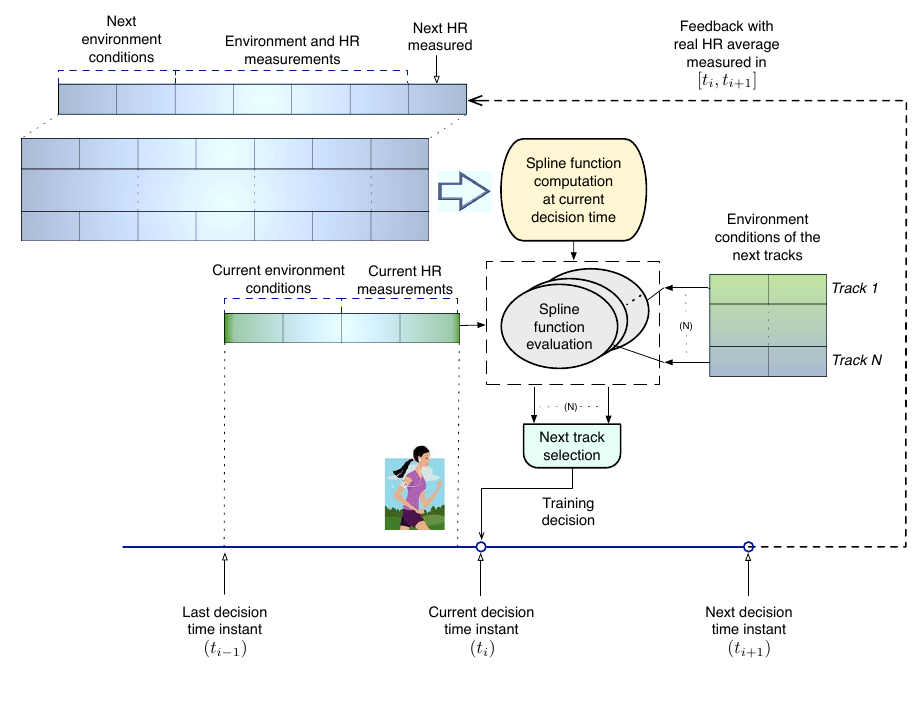
Figure 6. Decision engine